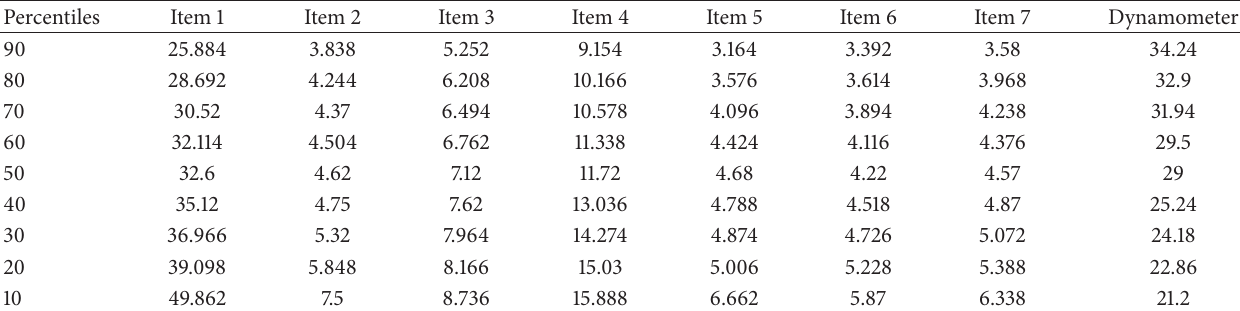
Table 8: 𝑛 = 21 , females, 6–19, nondominant hand, educational instruction: elementary school.